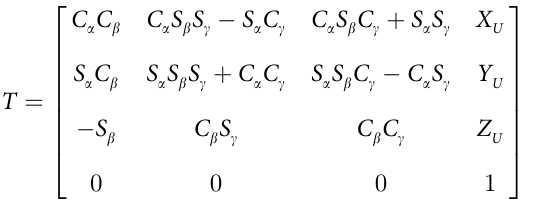
ffiffiffi p ¼ 3 (second actuator’s constrain plane) and y x c c